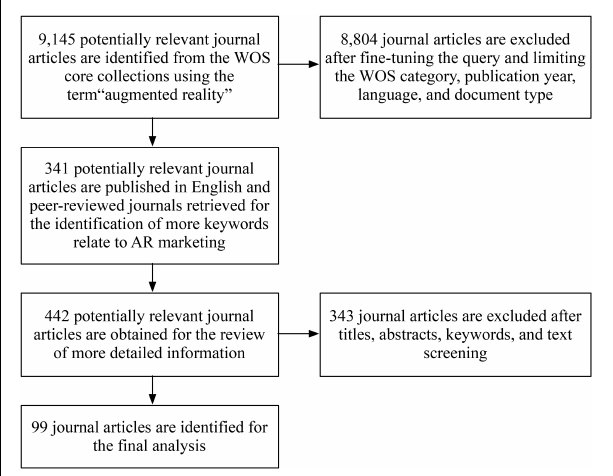
FIGURE 1 | The process of selecting the journal articles for final analysis.